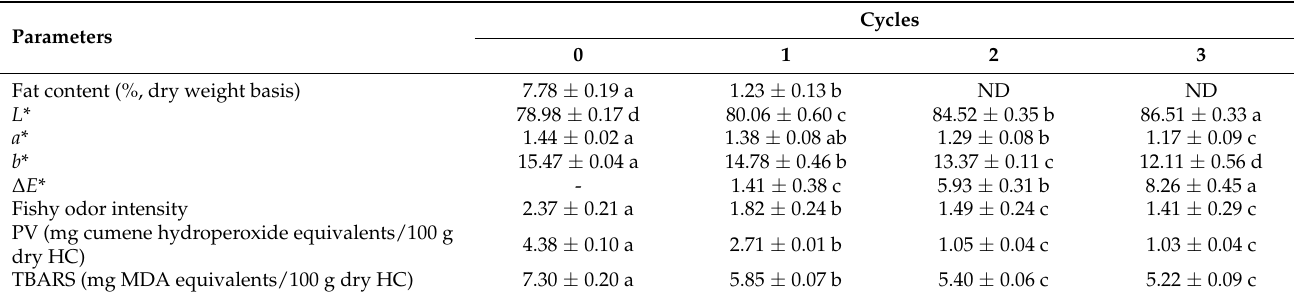
Table 3. Fat content, color, fishy odor intensity, peroxide value (PV), and thiobarbituric acid reactive substances (TBARS) of hydrolyzed collagen powder defatted with isopropanol for different